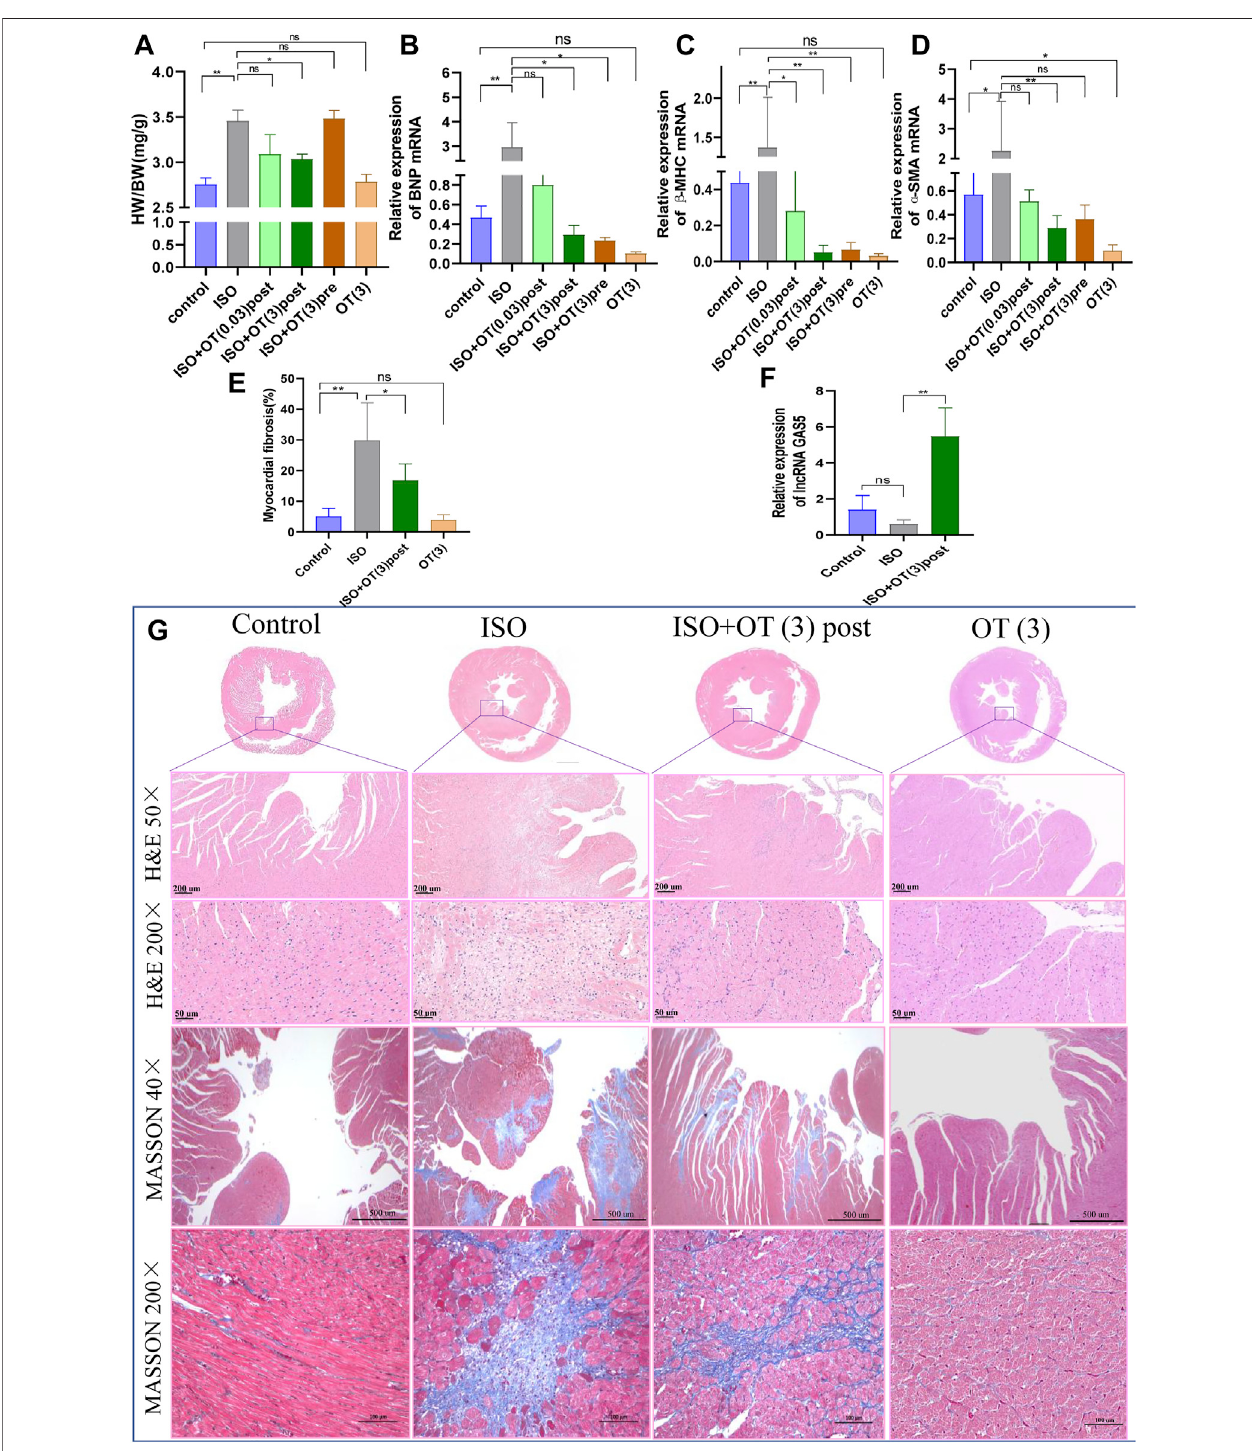
FIGURE 3 | OT alleviated cardiac hypertrophy caused by ISO administration along with up-regulation of lncRNA GAS5 expression. SD rats were treated with ISO and different concentrations of OT as described. (A) HW/BW ratio. (B − D) The expressions of BNP, β -MHC and α -SMA mRNA detected by qRT-PCR. (E) Quantitative morphometric analysisofMasson ’ strichrome stainingrepresentingmyocardial fi brosis. (F) Effects ofOT(3 ug/kg)postconditioning on theexpression oflncRNA GAS5. (G) Representative histopathological images of heart tissue sections stained with H&E, Masson ’ s Trichrome staining from the indicated groups. n (cid:2) 3 – 6 rats per experimental group. Data shown as mean ± sd, * p < 0.05 ** p < 0.01.